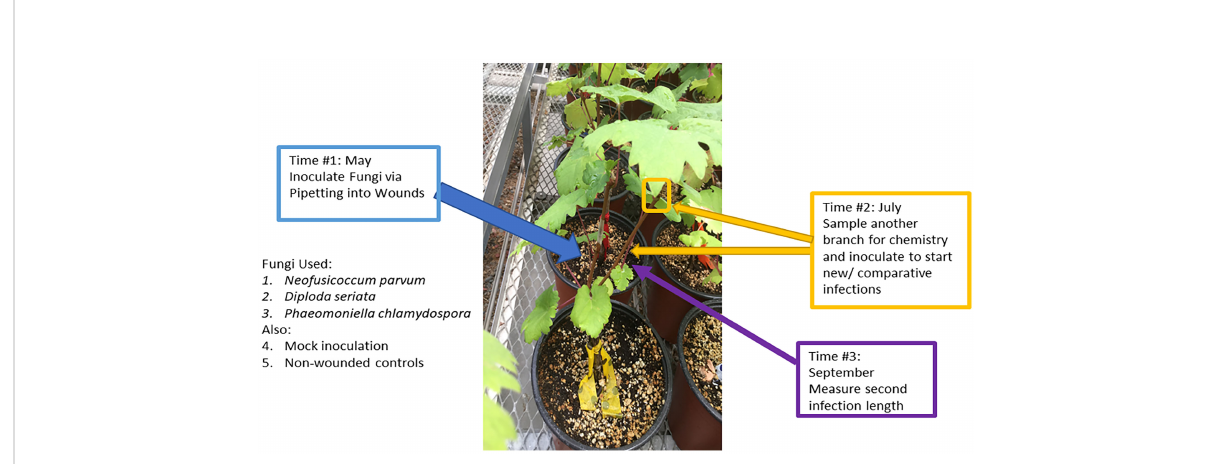
FIGURE 1 Overview of the experimental procedures. Second inoculations were applied on a second shoot two months after initial inoculation treatments, and at the same time woody shoots were sampled for